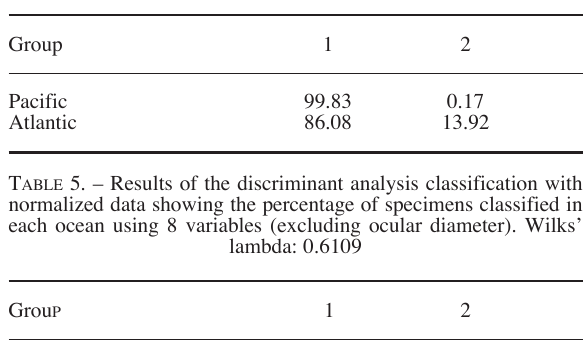
T ABLE 4. – Results of the discriminant analysis classification with normalized data showing the percentage of specimens classified in each ocean using 9 variables (total length was excluded as a result of the normalization). Wilks’ lambda: 0.2470